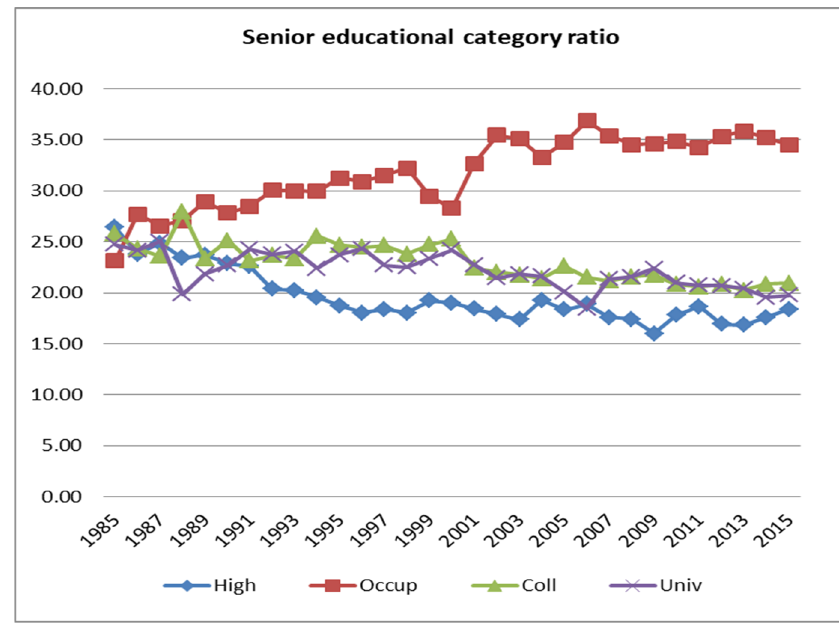
Figure 2. Senior educational category ratio. Source: same as Figure 1.